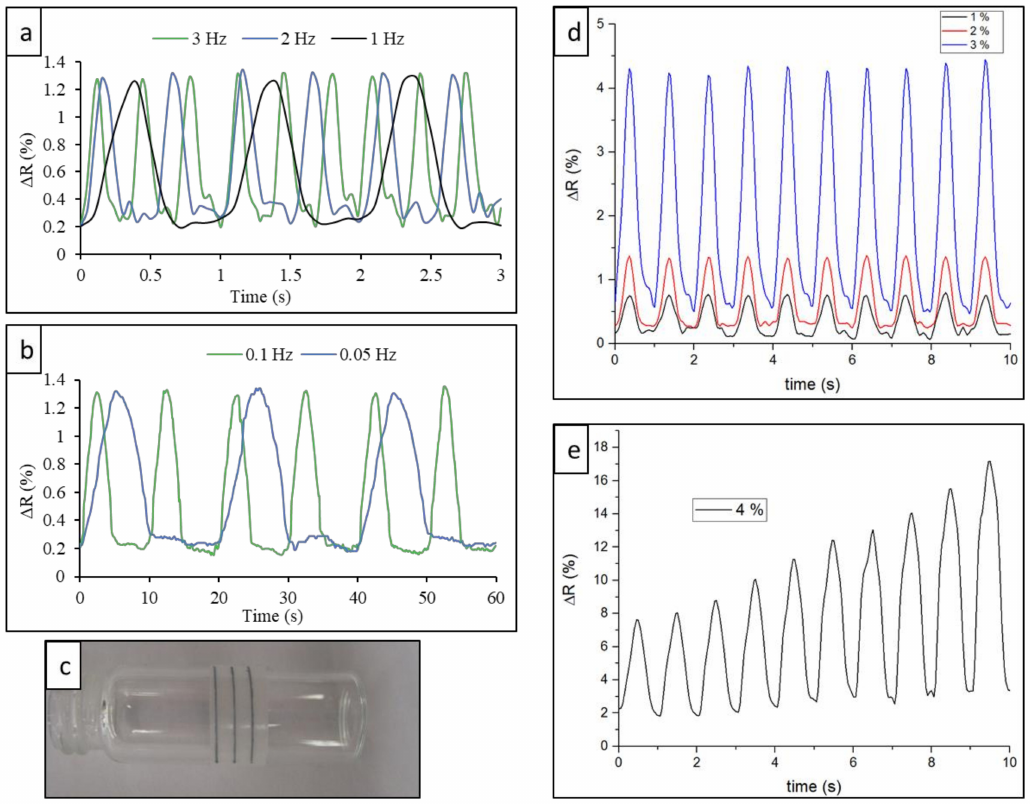
Figure 3. ( a ) Resistance fluctuations of a polymer electrode for 200 µ m displacement at 3, 2, and 1 Hz frequencies; ( b ) resistance fluctuations of a polymer electrode for 200 µ m displacement at 0.1 and 0.05 Hz frequencies; ( c ) flexible electrode bend around a glass tube of 1 cm diameter; ( d )